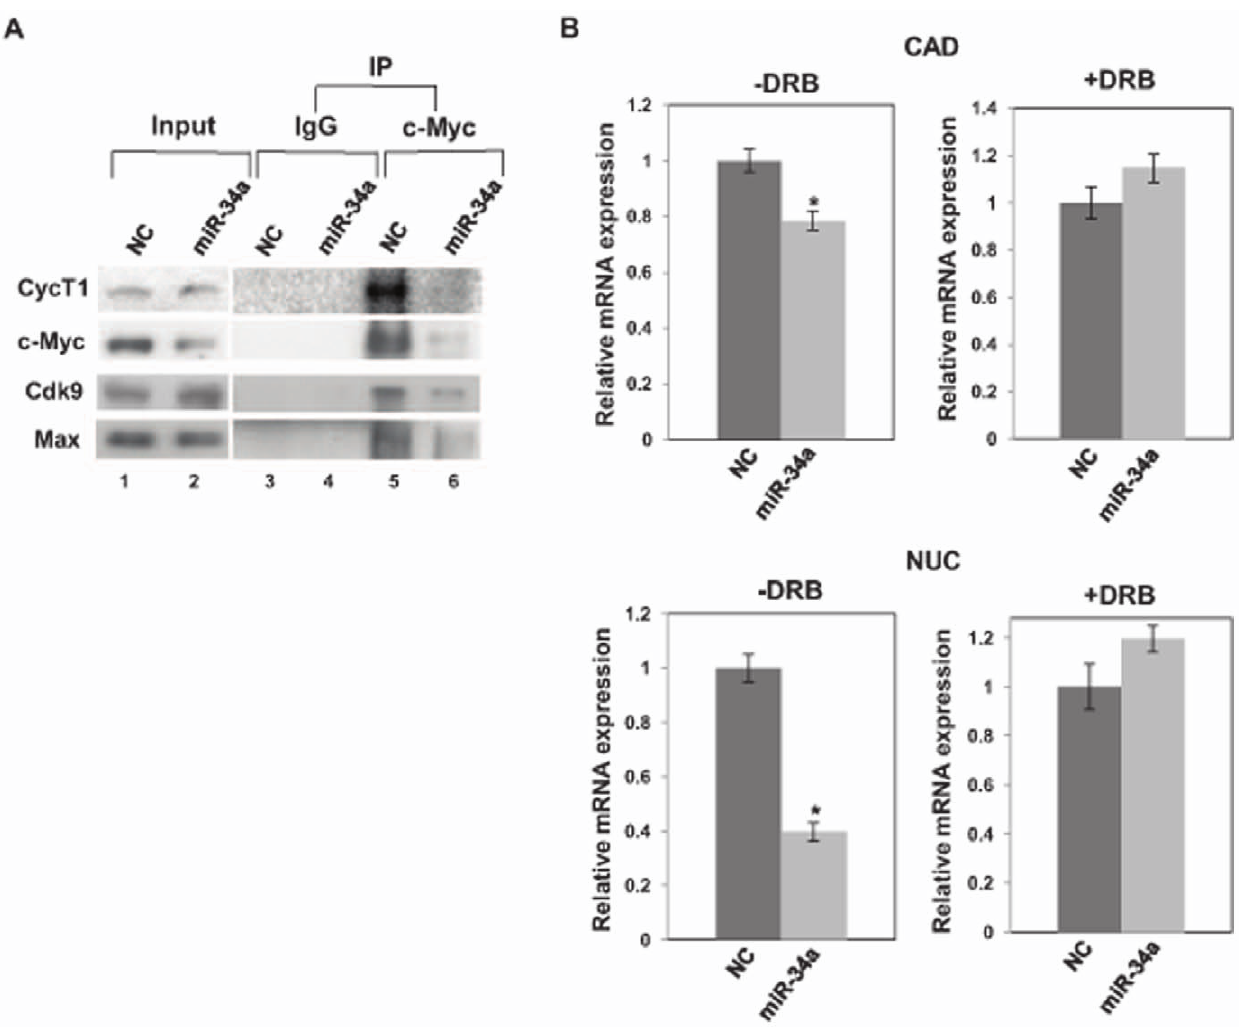
Figure 6. miR-34a suppresses the c-Myc-P-TEFb complex. (A) miR-34a suppresses the formation of the endogenous c-Myc-P-TEFb complex. PC-3 cells were transiently transfected with pre-miR negative control (NC) or pre–miR-34a for 72 h and total cell lysates were immunoprecipitated with c-Myc antibody or IgG (control), followed by Western blot analysis. (B) miR-34a suppresses CAD and NUC mRNA expression and DRB revereses the suppression. PC-3 cells were treated with 20 m M of DRB for 12 h and were transiently transfected with pre-miR negative control (NC) or pre–miR- 34a for 48 h. CAD and NUC mRNA level was analyzed by real-time PCR.